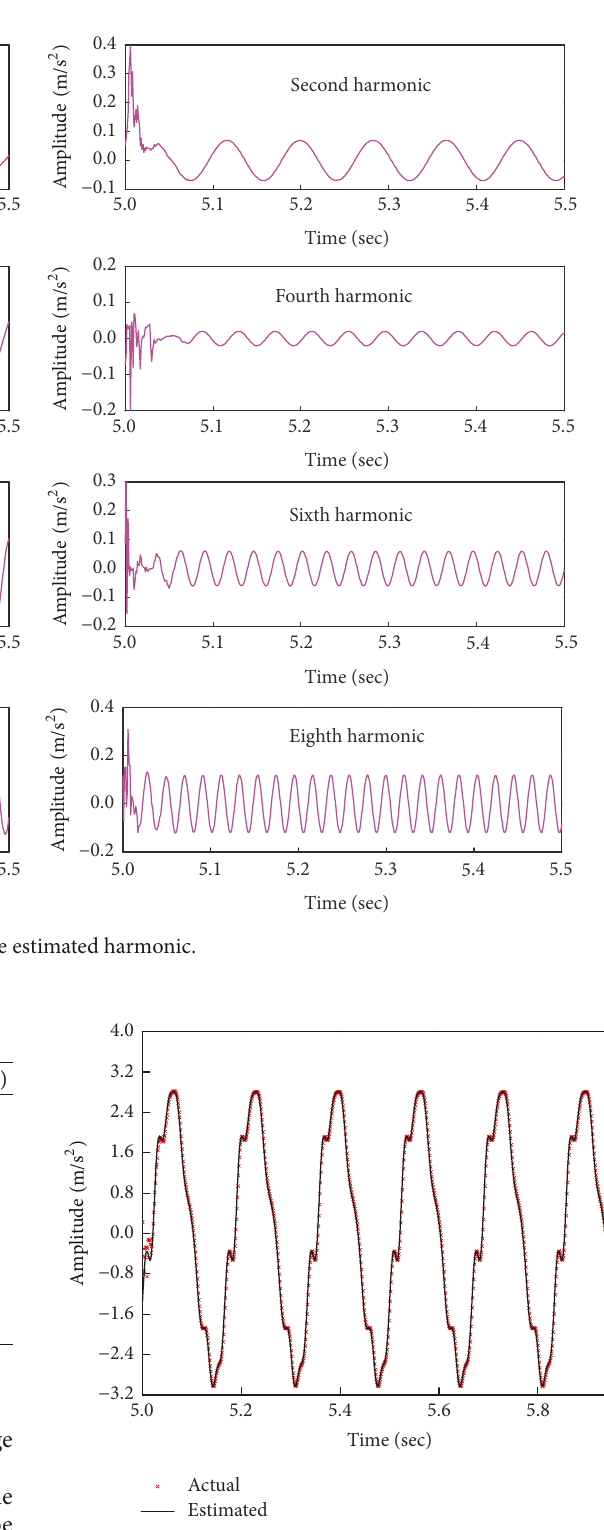
Figure 13: The estimated acceleration.